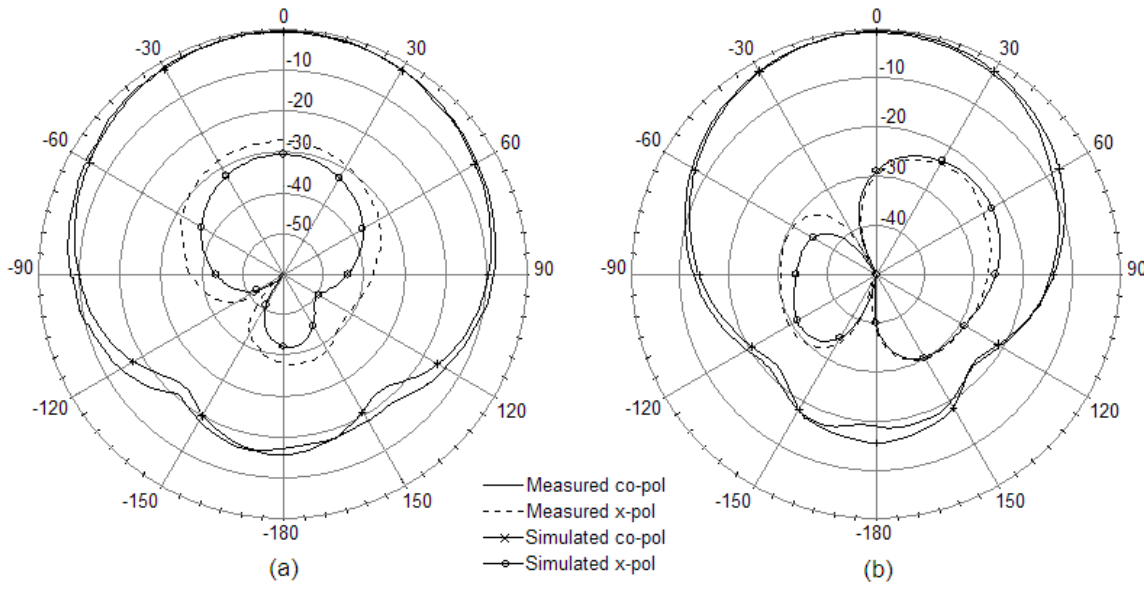
Figure 11. Measured and simulated radiation patterns of the antenna along with the installation base. ( a ) E-plane. ( b ) H-plane.